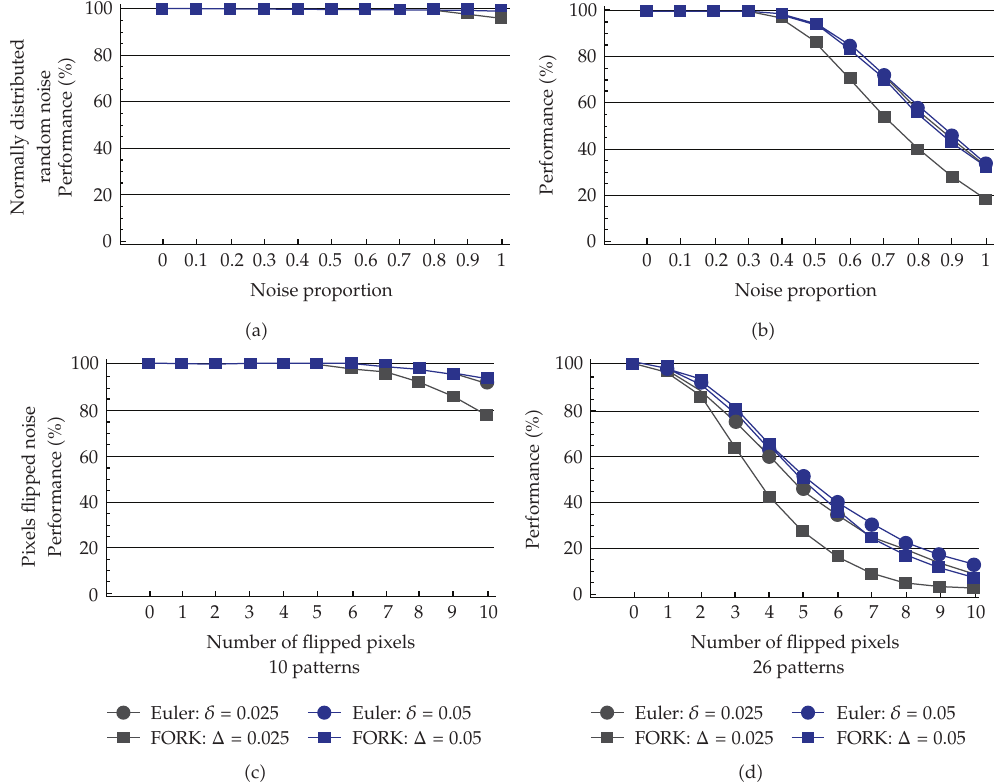
Figure 10: Performance comparison between Euler and FORK methods for di ff erent output parameters (cid:3) 0.05 and 0.025 (cid:4) . Upper left panel low memory load under normally distributed noise Upper right high memory load under normally distributed noise. Lower left low memory load under pixels flipped noise. Lower right high memory load under pixels flipped